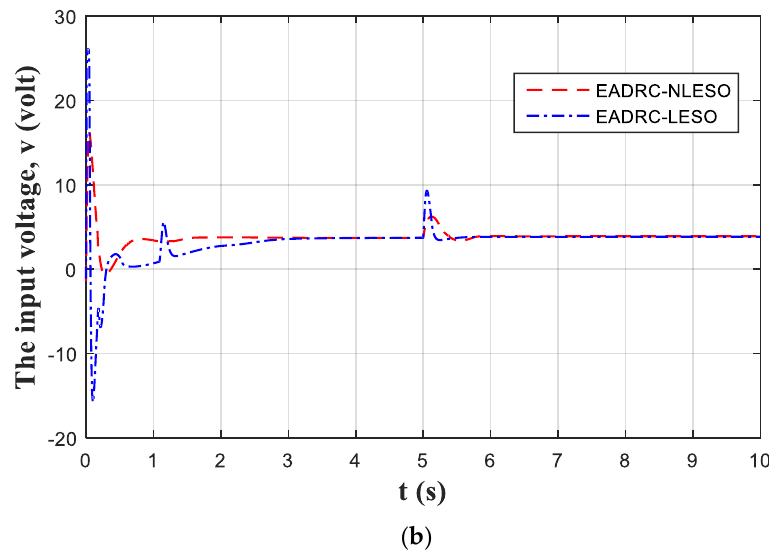
Figure 4. Angular velocity due to an external step disturbance of 2 N.m.